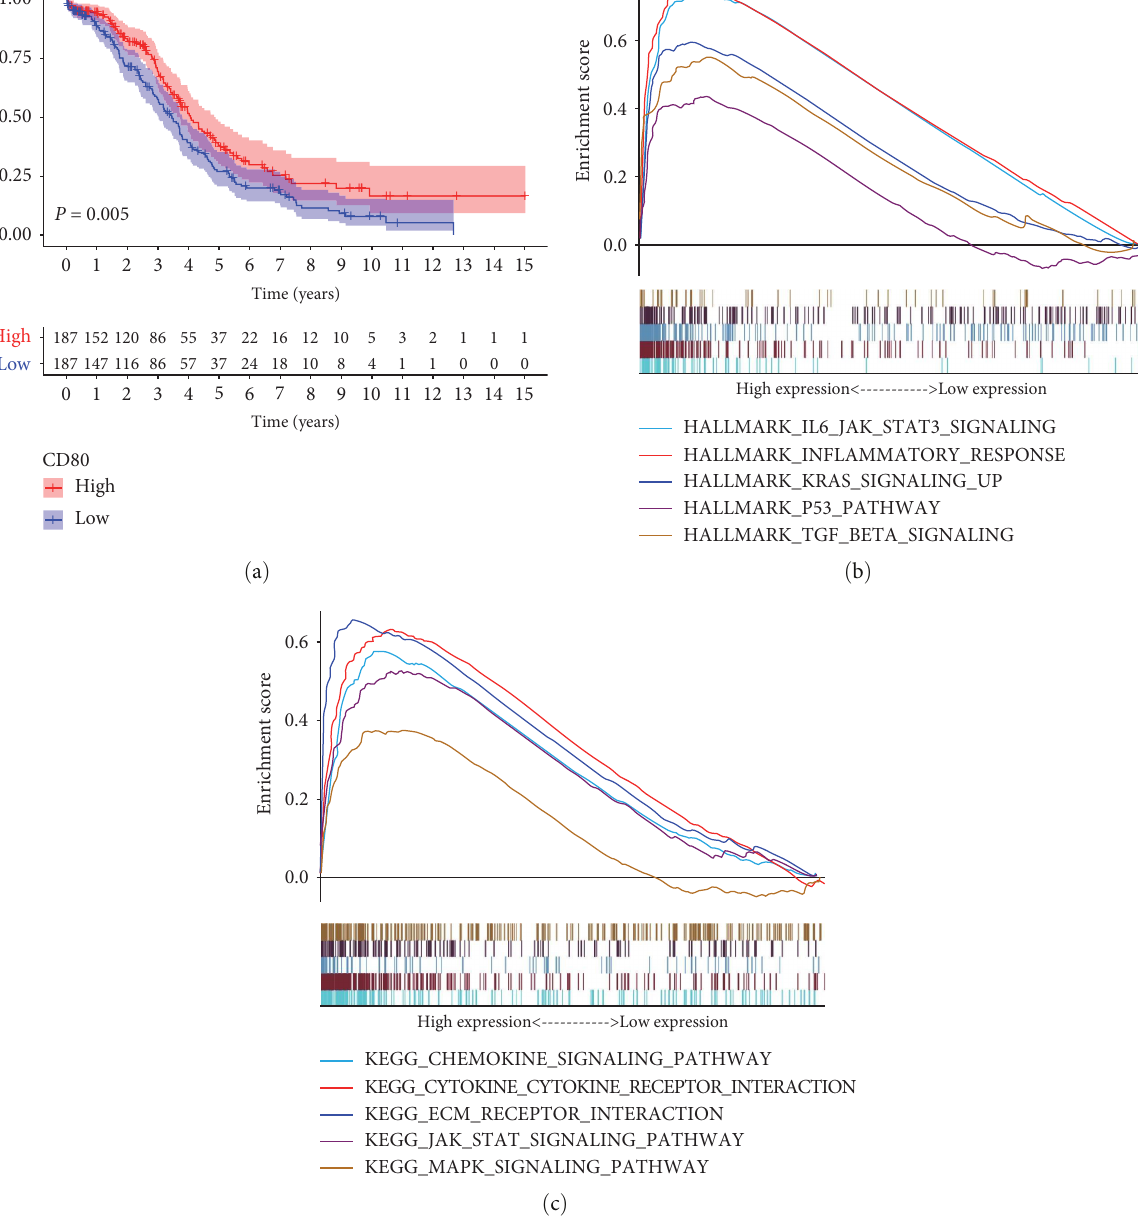
F IGURE 4: Survival analysis and GSEA. (a) Survival analysis for HGSOC patients with different CD80 expression. Patients were labeled with high expression or low expression depending on the comparison with the median expression level. (b) GSEA for samples with high IL-6 expression and low expression. Each line representing one particular gene set with unique color, and upregulated genes located in the left, approaching the origin of the coordinates; by contrast, the downregulated lay on the right of x -axis. Only gene sets with NOM P < 0 : 05 and FDR q < 0.06 were considered signi fi cant. (c) The enriched gene sets in HALLMARK collection by the high IL-6 expression sample. (d) Enriched gene sets in KEGG by samples of low IL-6